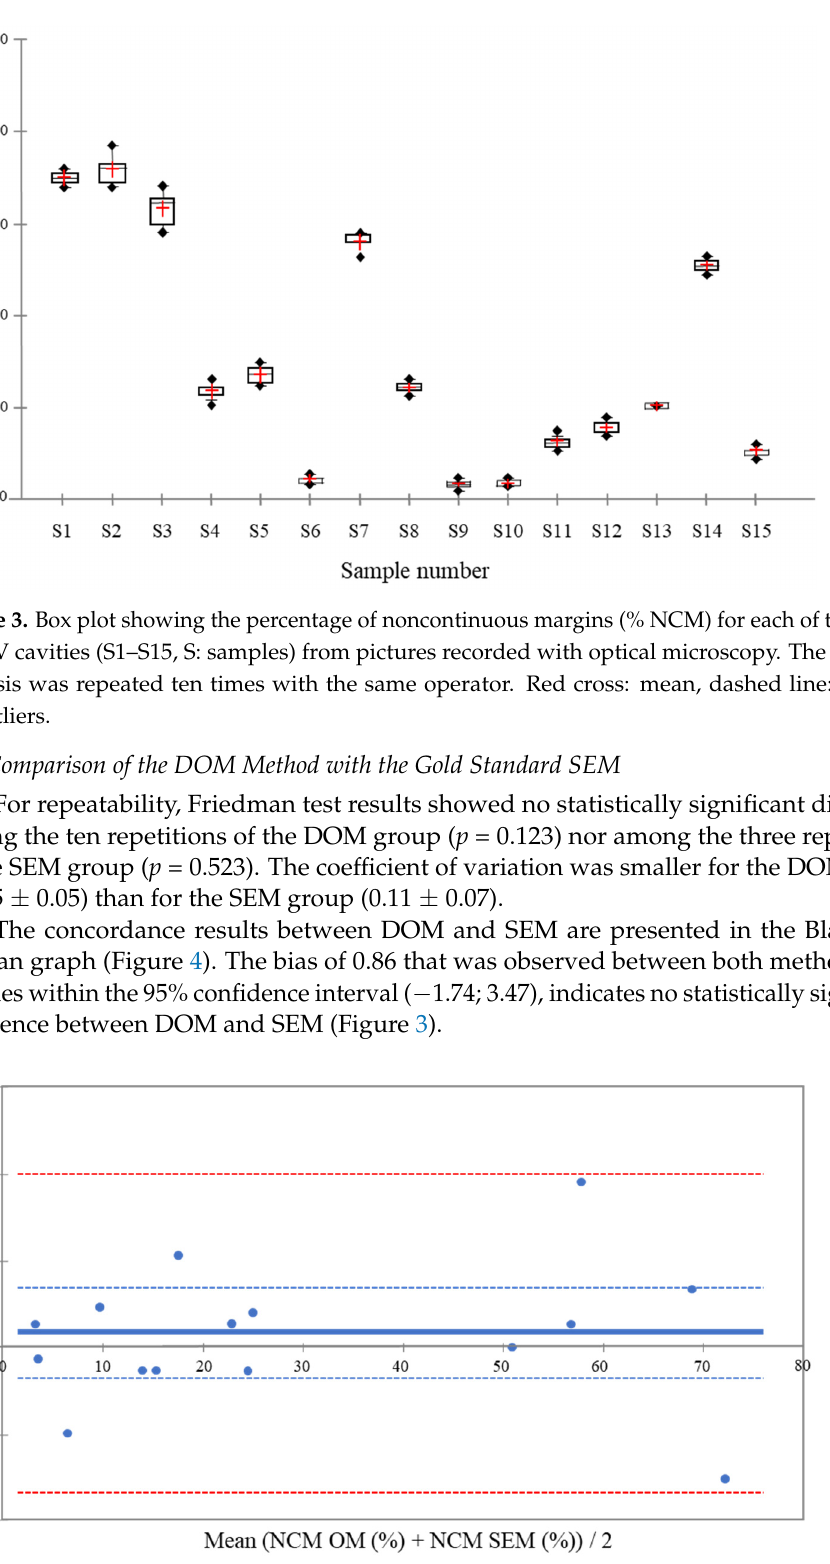
( b ) Figure 5. ( a ) Representation of the differences in the marginal analysis (percentage of noncontinuous margins) between the three operators (A, B and C) for all the studied samples (S1–S15, S: sample). ( b ) Box plot showing the variance between operators. The difference between operators is repre- sented by the linearity of the blue line. Operator C has a tendency to overestimate %NCM compared to the two other operators. Horizontal line: median. Boxes: 25–75%. Bars: range of non-outliers. Table 2. Two-way ANOVA table with interaction. Degree of freedom (DF), sum of squares (SS), variance (V), Fisher-test (F), p -value (P), percentage of overall variation from each component (% Contribution), p < 0.05. Source